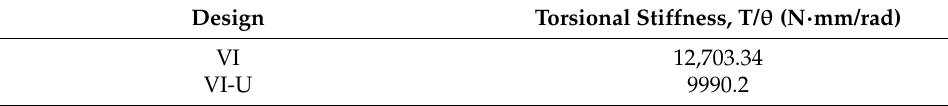
Table 7. Torsional stiffness values of VI and VI-U